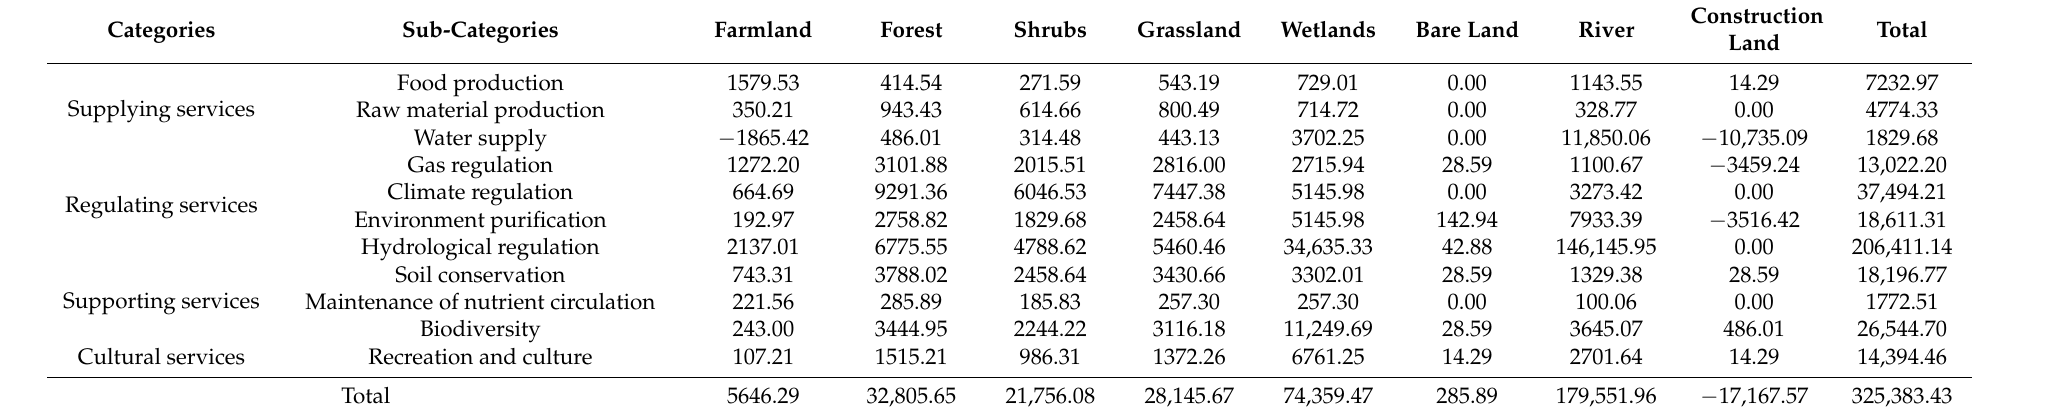
Table 4. Ecosystem service value per unit area in Hainan Province (CNY/hm 2